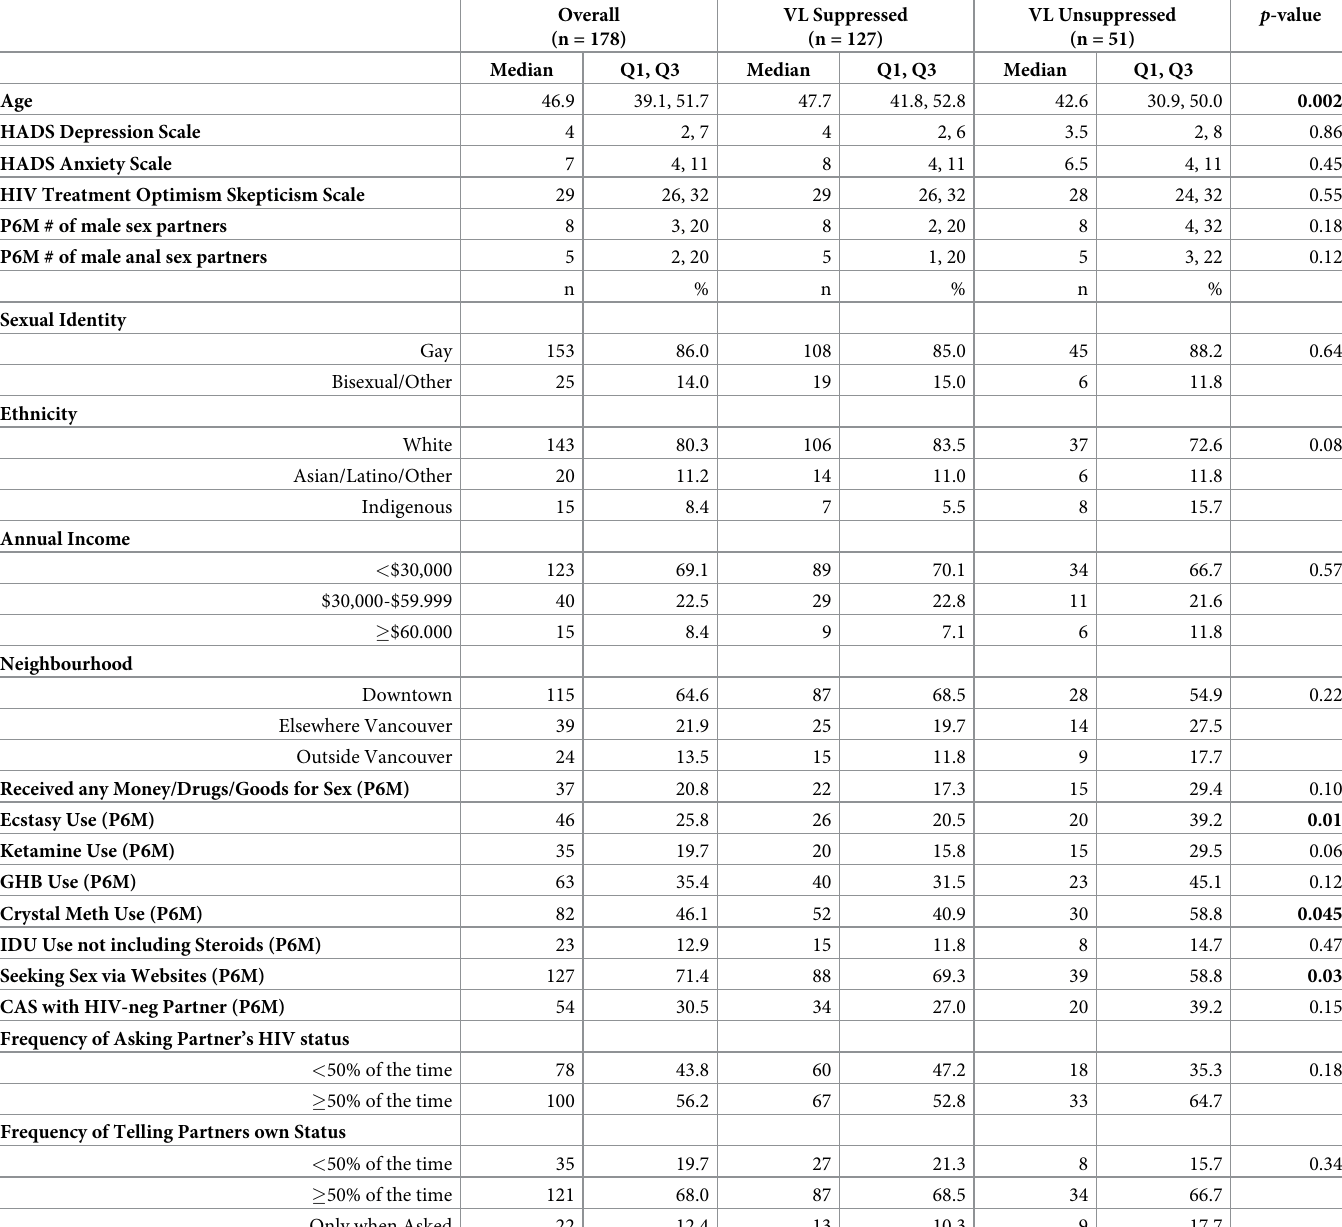
Table 1. Descriptive statistics of sample of gbMSM living with HIV included in GEE modelling (n =